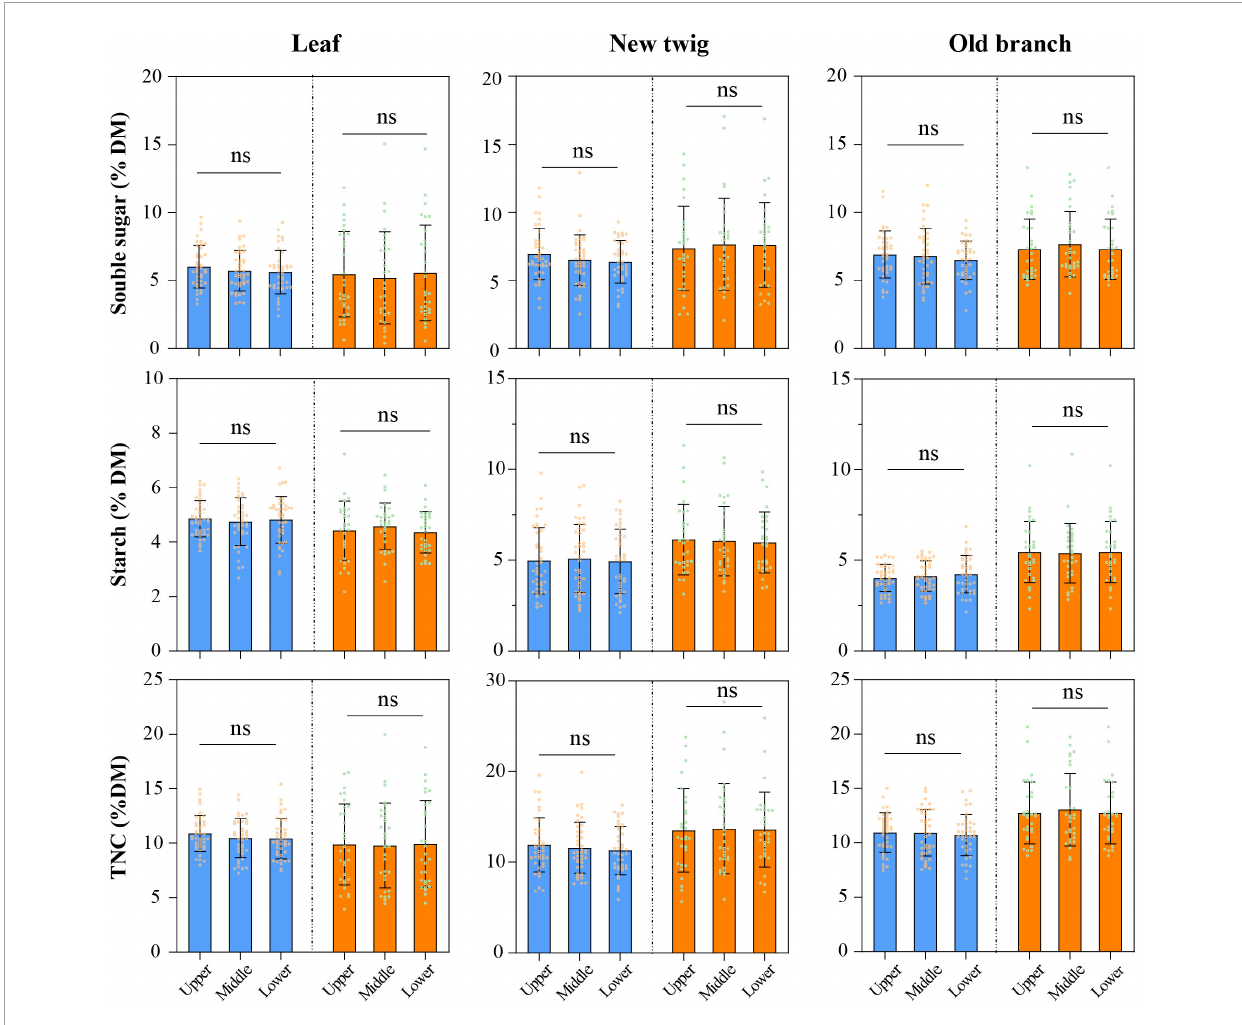
FIGURE4 Differences among mature tree canopy layers of species by different wood types. Blue represents diffuse-porous species, orange represents ring-porous species. ns, no significant